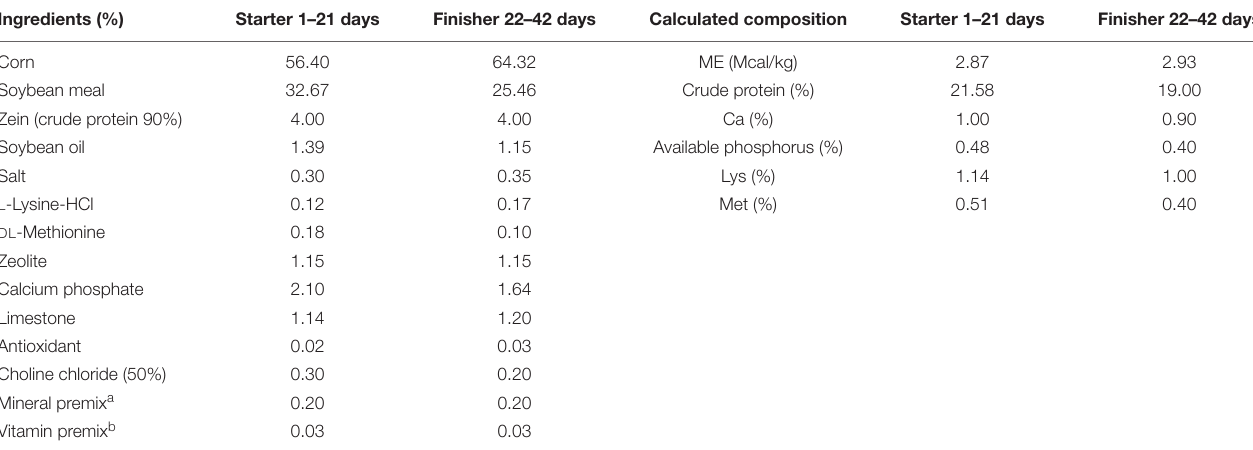
TABLE 1 | Ingredient and nutrient composition of the basal